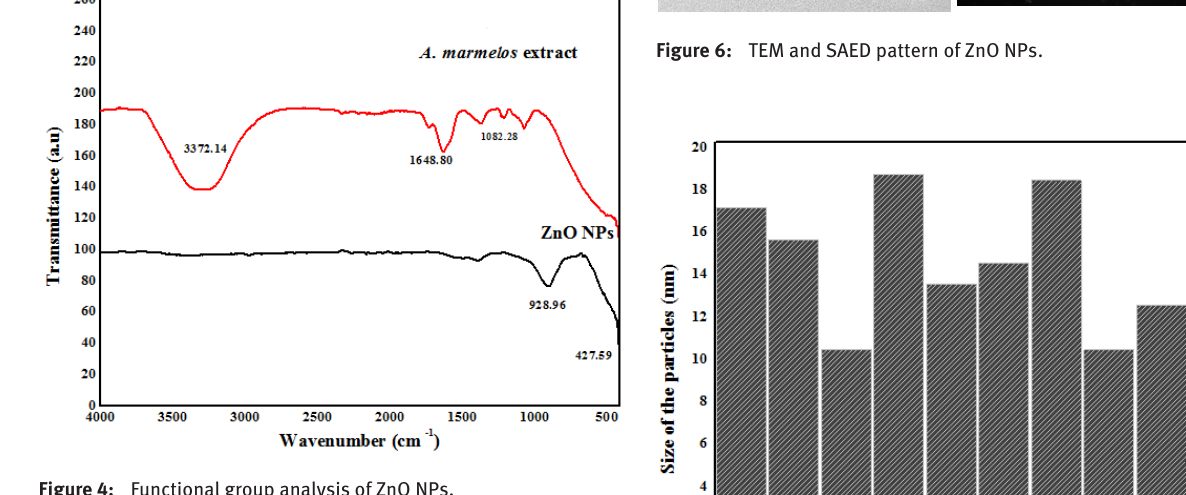
Figure 4: Functional group analysis of ZnO NPs.